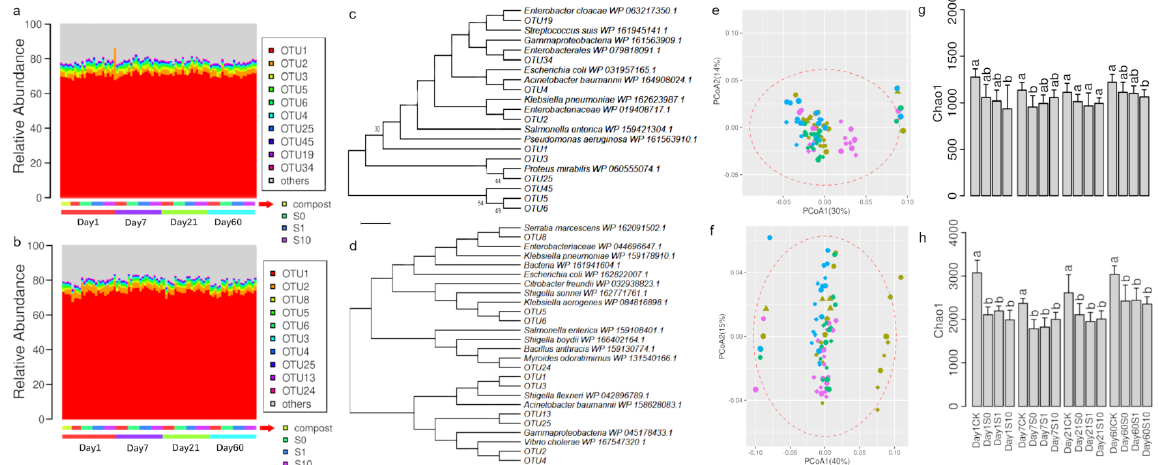
Figure 4. The relative abundance of most detected genotype for sul1 ( a ) and sul2 ( b ) gene, BLASTP analysis of sul1 ( c ) and sul2 ( d ) gene, PCoA (principal coordinate analysis) of sul1 ( e ) and sul2 ( f ) gene composition, Chao1 index of sul1 ( g ) and sul2 ( h ) in different treatments. CK: soil; S0: soil amended with compost; S1: soil amended with compost and 1 mg kg − 1 of sulfadiazine; S10: soil amended with compost and 10 mg kg − 1 of sulfadiazine.